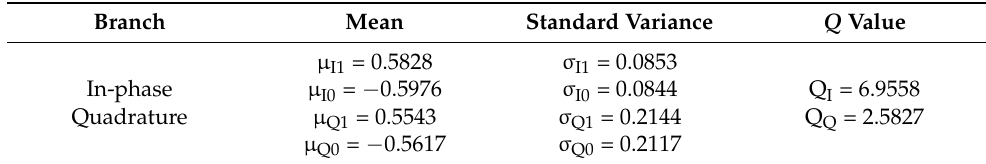
Figure 6. ( a ) In-phase signal Level 0 histogram; ( b ) in-phase signal Level 1 histogram; ( c ) quadrature signal Level 0 histogram; ( d ) quadrature signal Level 1 histogram. Table 1. Results of histogram